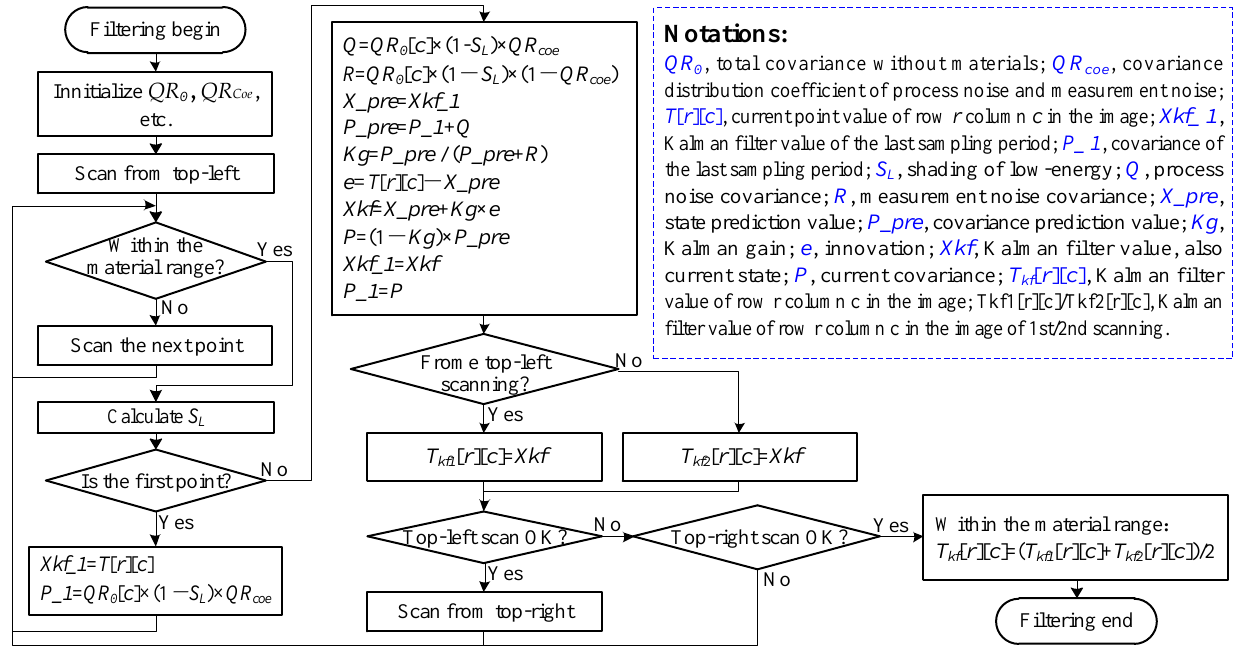
Figure 4. The block diagram of improved adaptive Kalman filtering